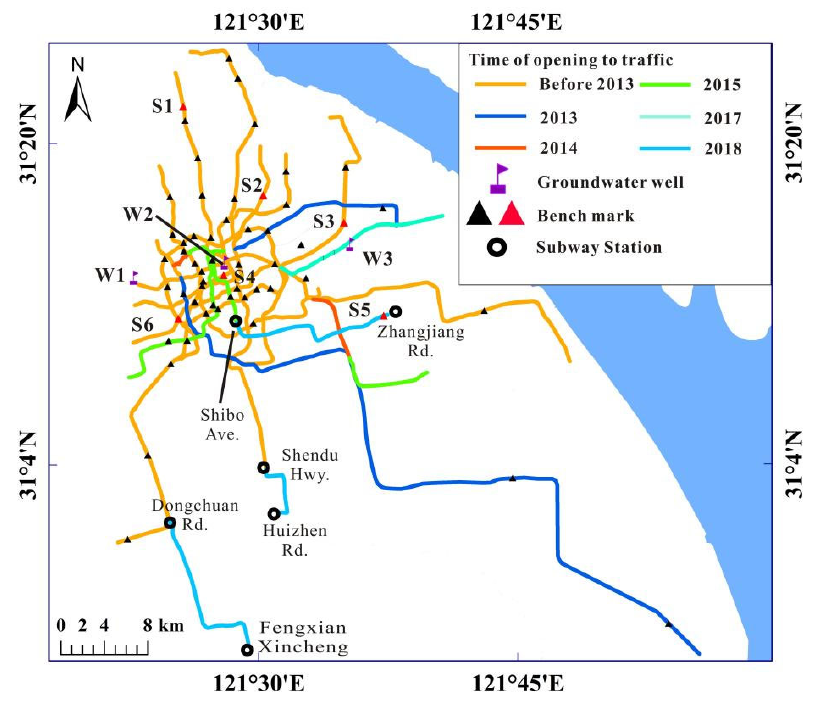
Figure 2. The distribution of the subway lines with different times of opening to traffic, the bench- marks, and the groundwater wells in the study area.